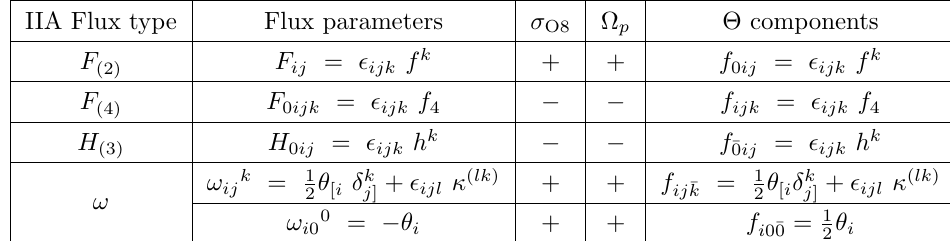
Table 5 . The explicit dictionary between type IIA (cid:13)uxes consistent with the O8 involution and deformation parameters of N = (1 ; 1) supergravity in six dimensions.